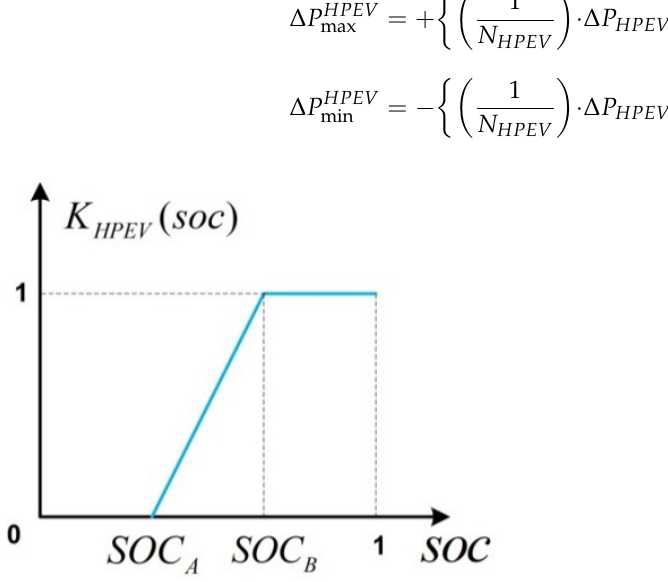
Figure 2. Characteristic of K HPEV vs. SOC in idle mode case.